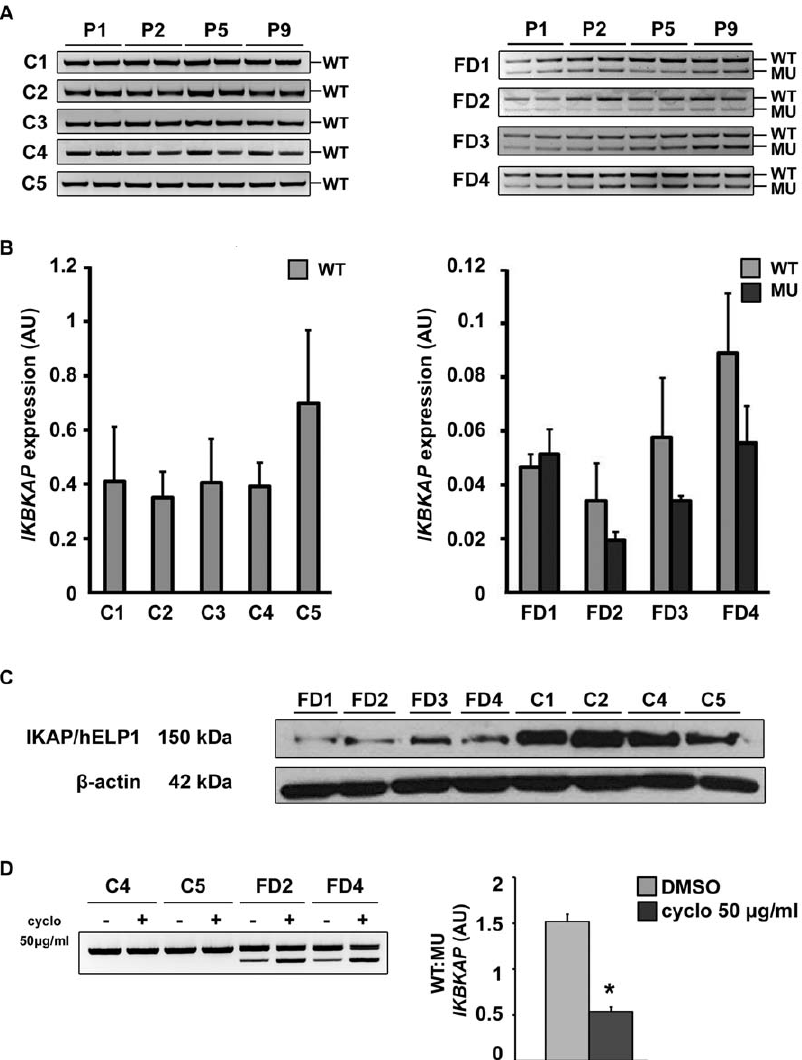
Figure 2. Expression of IKBKAP transcripts and IKAP/hELP1 protein in hOE-MSCs. A, agarose gel electrophoresis of end-point RT-PCR products showing both WT and MU transcripts of IKBKAP gene for control (left panel) and FD hOE-MSCs (right panel) at cell passage 1,2,5,9. B, graph of the mean level of expression of IKBKAP alternative transcripts in control (left panel) and FD hOE-MSCs (right panel) at cell passages 1,2,5,9, determined by absolute RT-qPCR. ABL1 was used as a reference gene for normalization. Error barrs denote standard error. C, western blot analysis of total lysate from 4 controls and 4 FD hOE-MSCs using monoclonal anti-IKAP/hELP1 antibody (upper panel). Anti- b -actin was included to show equal loading (lower panel). D, NMD pathway was blocked by the translation inhibitor cycloheximide and results in an elevated expression of MU transcripts in FD cells (agarose gel electrophoresis, left panel). Results are confirmed with absolute qPCR normalized with ABL1 (right panel).